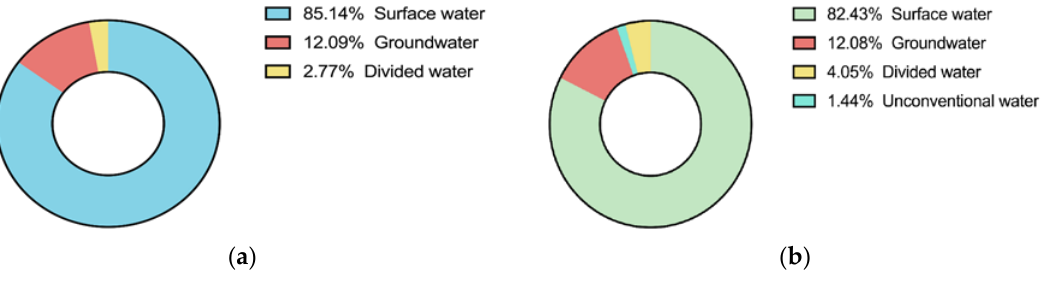
Figure 9. Water supply ratio of each water source in Huaihe in ( a ) 2020, ( b ) 2050.